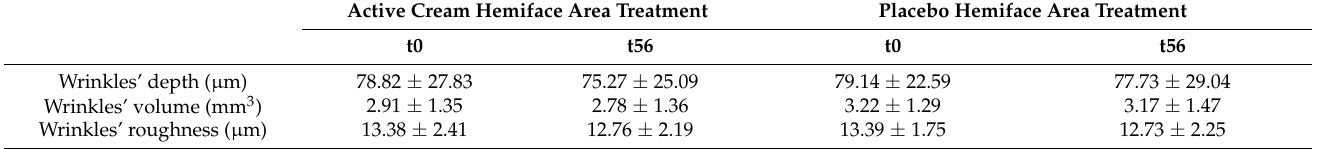
Table 2. Mean values of the wrinkles’ depth and volume and the skin roughness in the crow’s feet area before (t0) and after 56 (t56) consecutive days of application of the active cream and the placebo, twice daily, through Primos Premium analysis. The results are expressed as mean ± SD ( n = 22). Active Cream Hemiface Area Treatment Placebo Hemiface Area Treatment